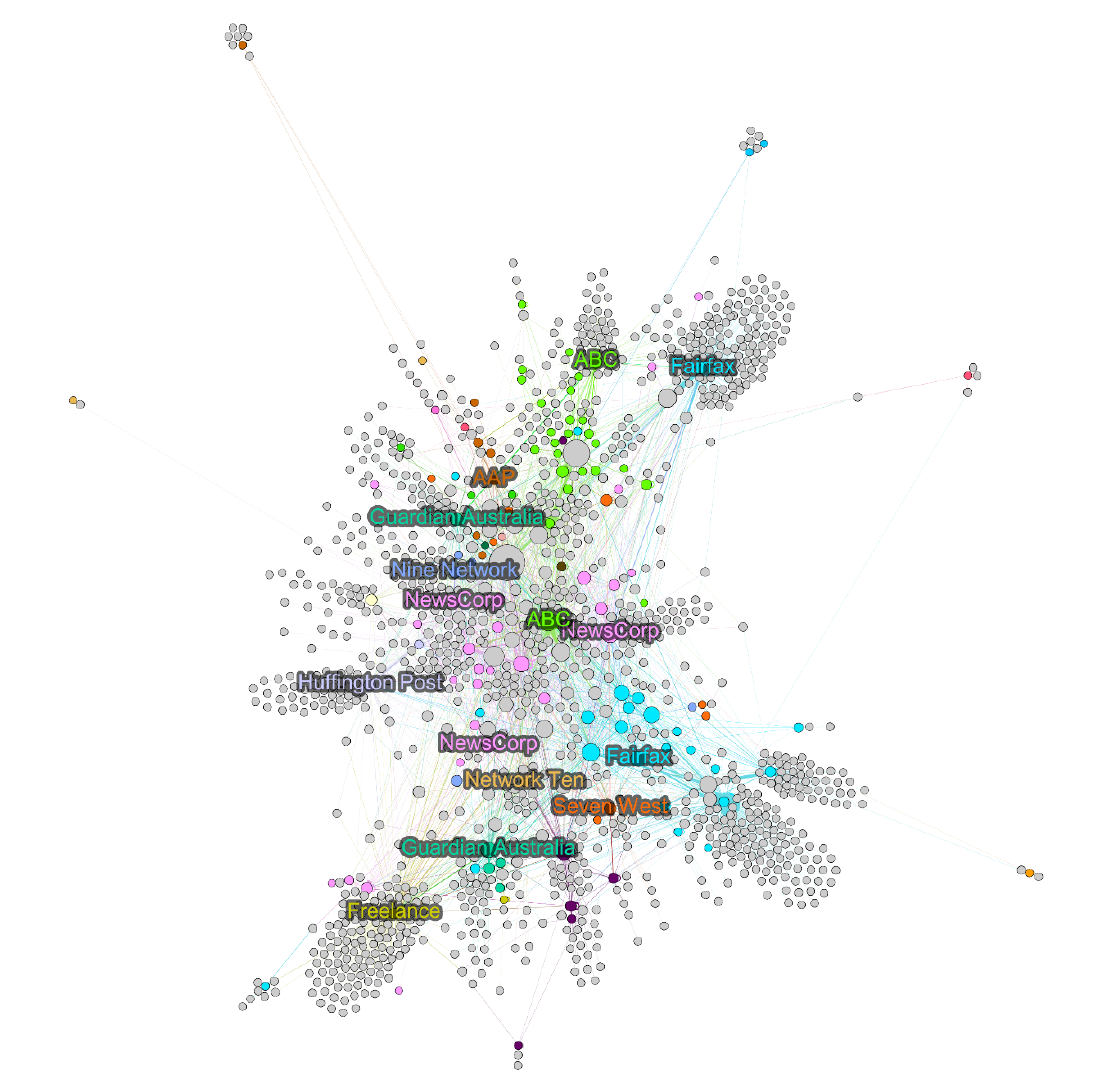
Figure 2. Press Gallery @mention network for accounts with degree > 9 (2017). Network diameter: 6 (average geodesic distance: 3.129). Network density: